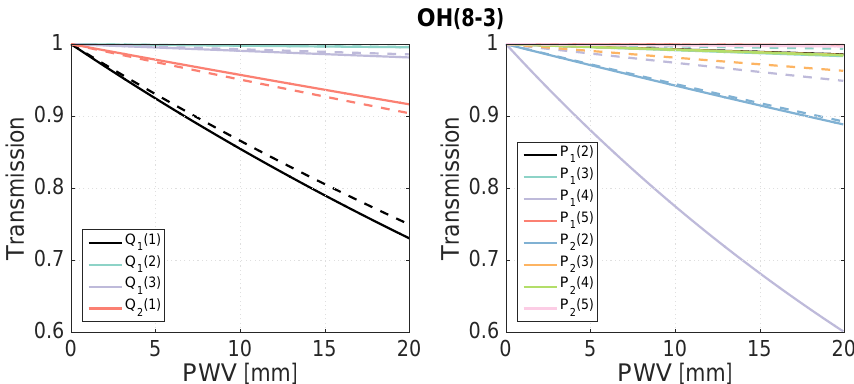
Figure 4. Water vapour transmission of the OH(8–3) lines, measured by HiTIES, as a function of precipitable water vapour (PWV). The left panel shows the Q-branch lines and the right panel, the P branch. Solid lines represent the e component of the lambda-doubled line, and the dashed lines represent the f component.